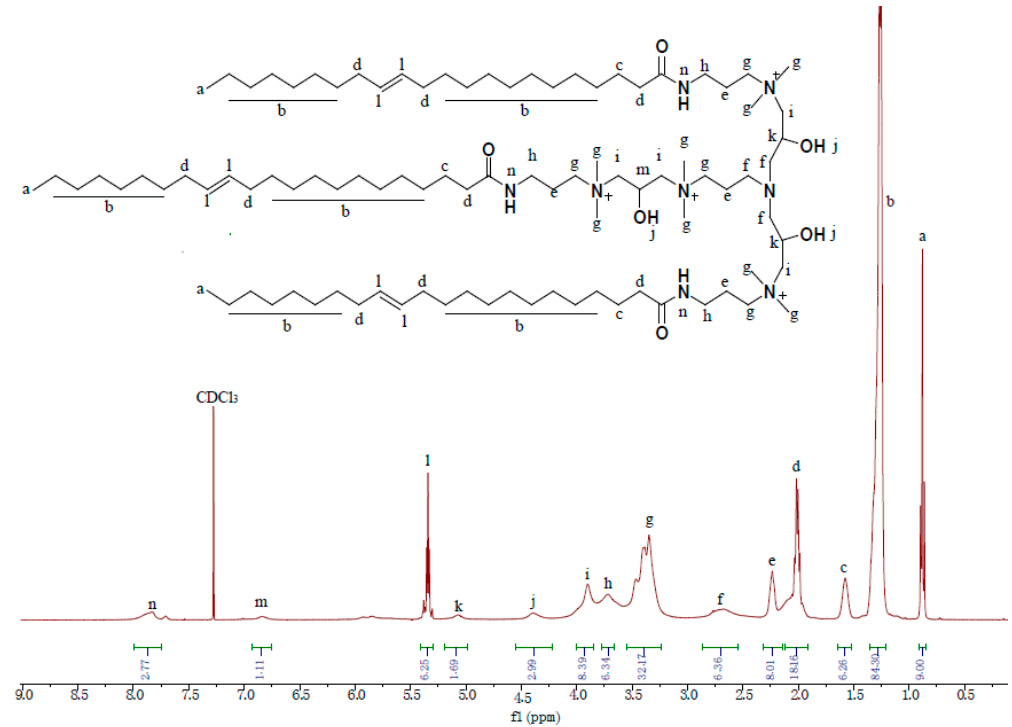
Figure 2. 1 H NMR spectrum of VES-T in CDCl 3 .